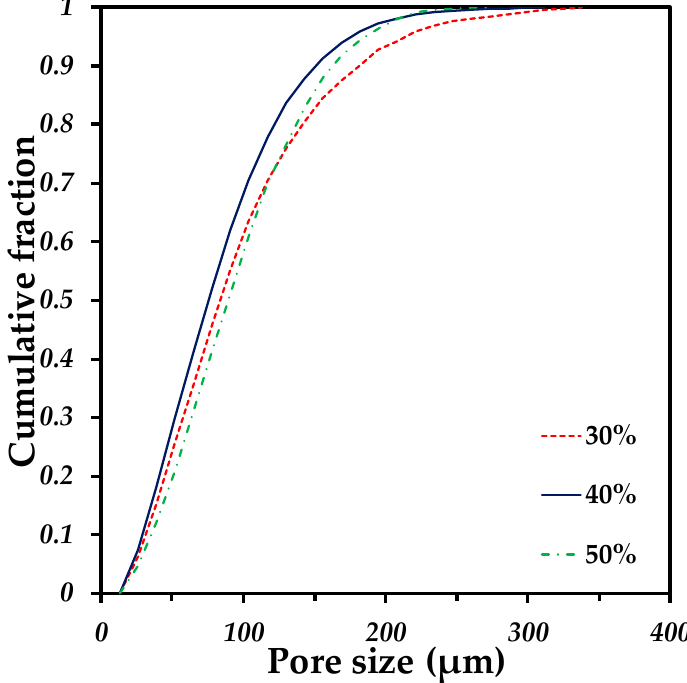
Figure 7. Pore size distribution of Ti64/20Ag samples containing different volume fractions of pore formers.